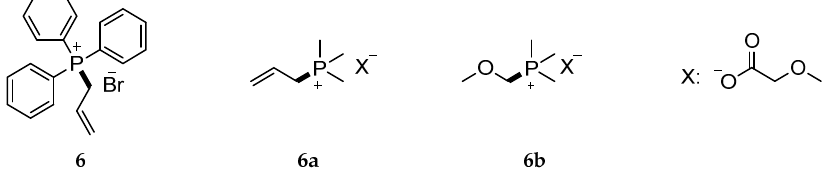
Figure 4. Chemical structures of phosphonium derivatives: 6 , 6a and 6b .